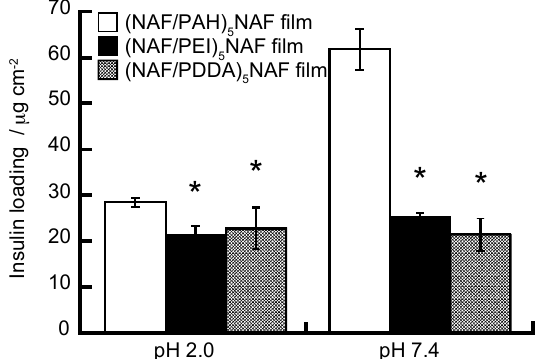
Figure 6. Insulin loading on (NAF/PAH) 5 NAF (open columns), (NAF/PEI) 5 NAF (filled columns), and (NAF/PDDA) 5 NAF (half-filled columns) films. The LbL films were exposed to a 1 mg mL − 1 insulin solution with 10 mM acetate buffer (pH 2) or 10 mM Tris buffer (pH 7.4). All buffer solutions contained 150 mM NaCl. * p < 0.05 one-way ANOVA and Dunnett’s test vs. (NAF/PAH) 5 NAF film.